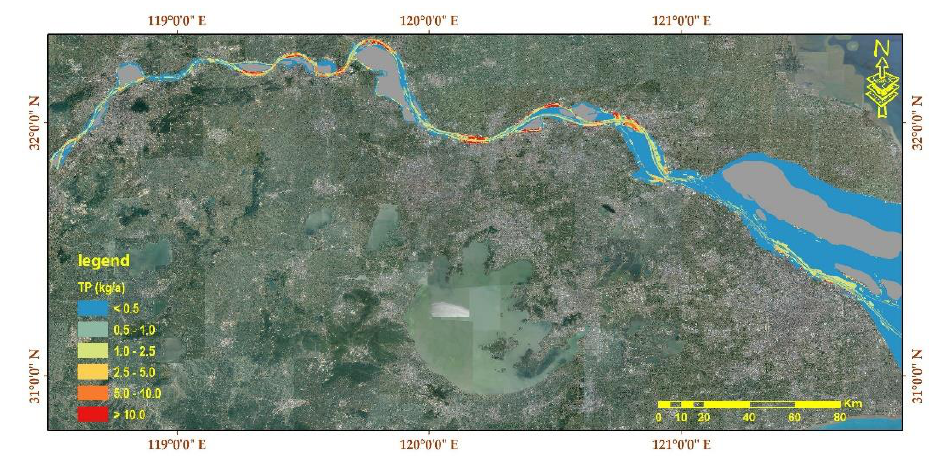
Figure 13. TP generation distribution.